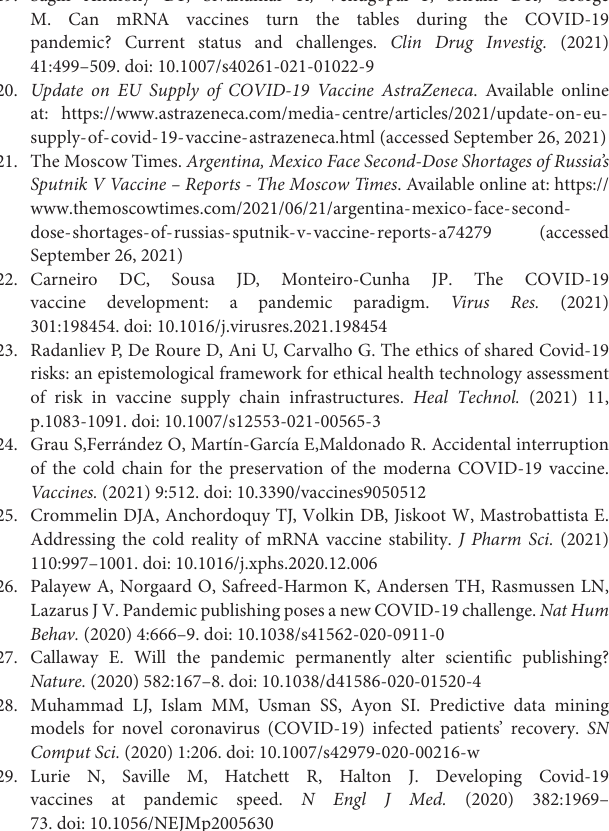
Supplementary Table 1 | List of publications used for the semi-automated artificial intelligence (AI) risk calculation.